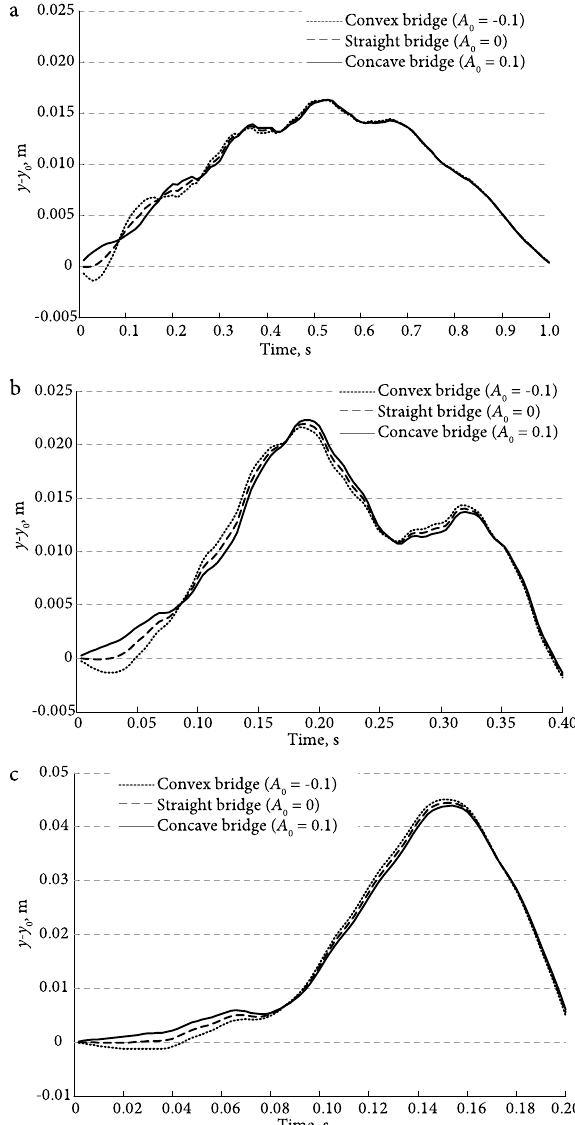
Fig. 3. Variation of the deflection at mid-point of the bridge under moving mass load (centripetal and Coriolis effects involved) with respect to time t: a – v = 10 m/s; b – v = 25 m/s; c – v = 50